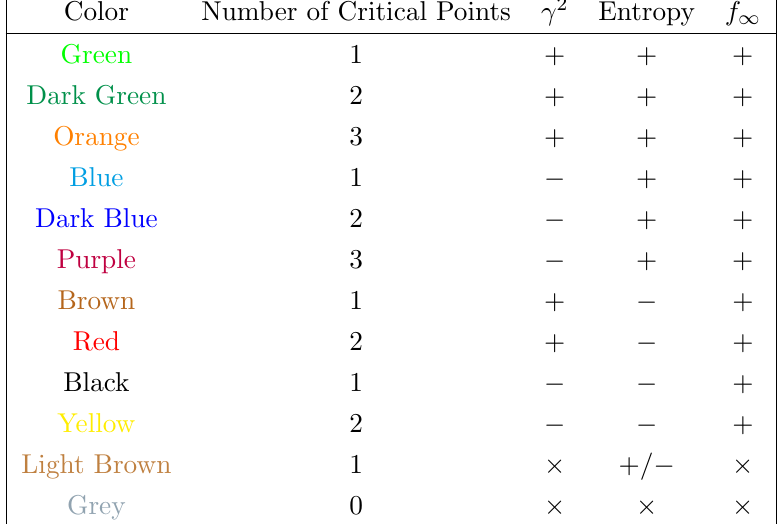
Table 1 . Color coding for phase space of constraints . This table illustrates the code for (cid:12)gures 3, 6 and 11 that illustrate how many critical points are present at each point in the parameter space ( (cid:12) 3 , (cid:11) 4 ). For completeness we consider both the existence and signs of (cid:13) 2 , the entropy, and f 1 . It is only when the signs of all three are positive that we get physical critical points. The ‘ (cid:2) ’ for f 1 means that eq. (2.6) does not have any positive real solution; in other cases it means the corresponding critical quantities are either negative or not